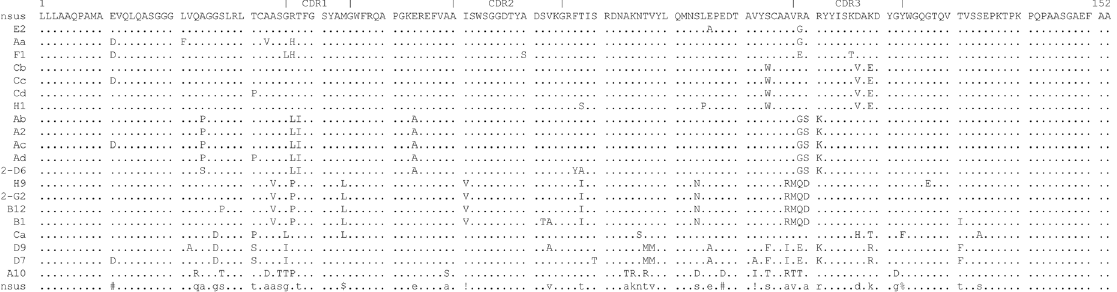
Fig 5. Sequences of antibodies studied in this work. Sequences are shown as a difference plot where a dot represents identity with the consensus sequence. Novel antibodies are identified by a > symbol and their two-letter abbreviations as used the in the text. Class A through D antibodies are shown for comparison and identified by name and class. Complementarity Determining Regions 1 through 3 are